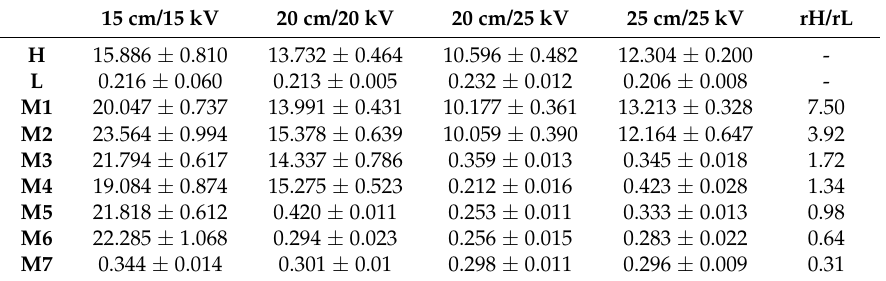
Table 2. Size ( µ m) of electrospun fibers obtained from H, L, and M solutions (mean value ± SE; n = 30). 15 cm/15